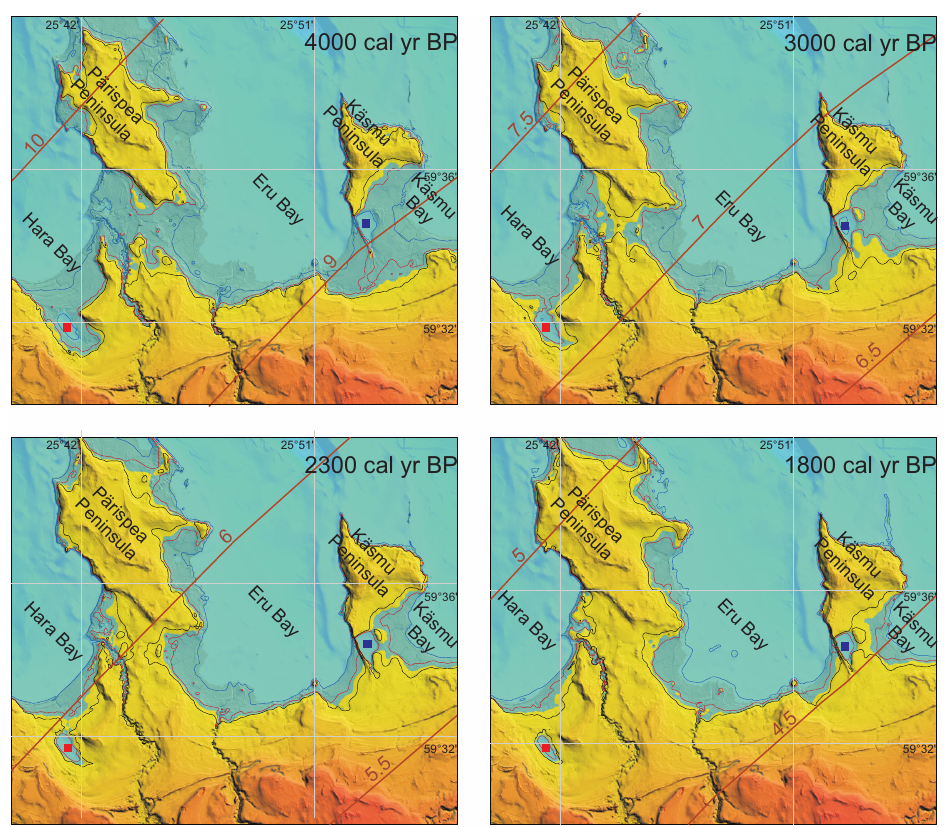
Fig. 4. Palaeogeographic maps for time windows 4000, 3000, 2300 and 1800 cal yr BP. Modelled water level surface isobases are indicated by brown lines together with altitudes in metres a.s.l. The shoreline location is shown together with a possible modelling error in the range of ! 1 m (black line + 1 m, red line  1 m); the blue line corresponds to the modelled water depth of 5 m. The reconstructions are overlaid by LIDAR elevation data (Estonian Land Board) to visualize the location of the present-day land (greenish) and sea (blue). Lake Lohja is shown by a red square, Lake Käsmu by a blue square. Reconstruction by J. Vassiljev.